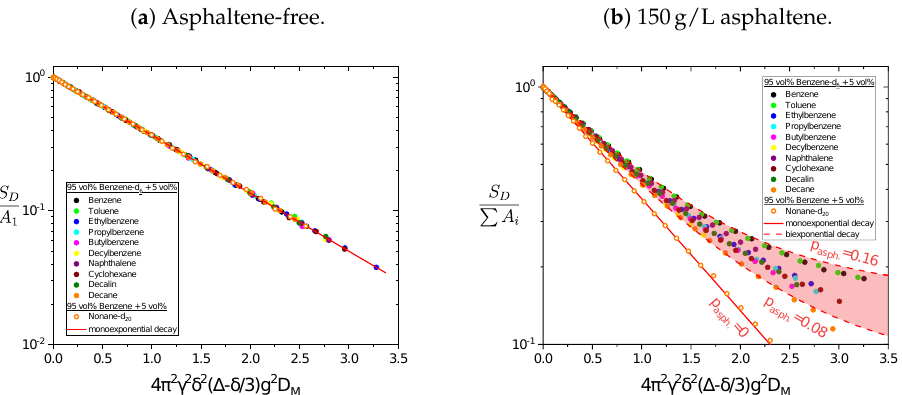
Figure 15. PGSTE signal decay of the protonic maltenes and nonane-d 20 in the ( a ) asphaltene-free and the ( b ) asphaltenic solution. The solid line represents a monoexponential decay, while the area between the dashed lines corresponds to biexponential decays with different relative contri- butions p asph. of the asphaltene to the decay. The diffusion coefficient of the asphaltene was fixed at D asph. = 3.6 × 10 − 11 m 2 /s. To obtain the signal decay of nonane-d 20 the gradient strength was varied up to 5T/m. ( a ) Aromatic protons.